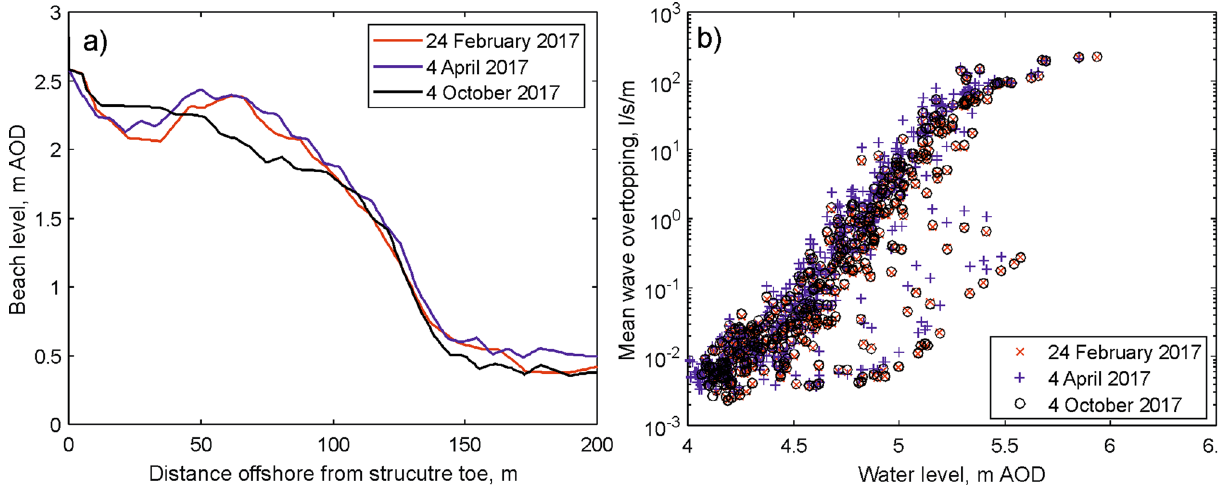
Figure 5. ( a ) Beach profiles collected during 2017. ( b ) Overtopping predictions calculated for each profile, showing consistently larger overtopping in April compared to February and October (note the logarithmic y-axis